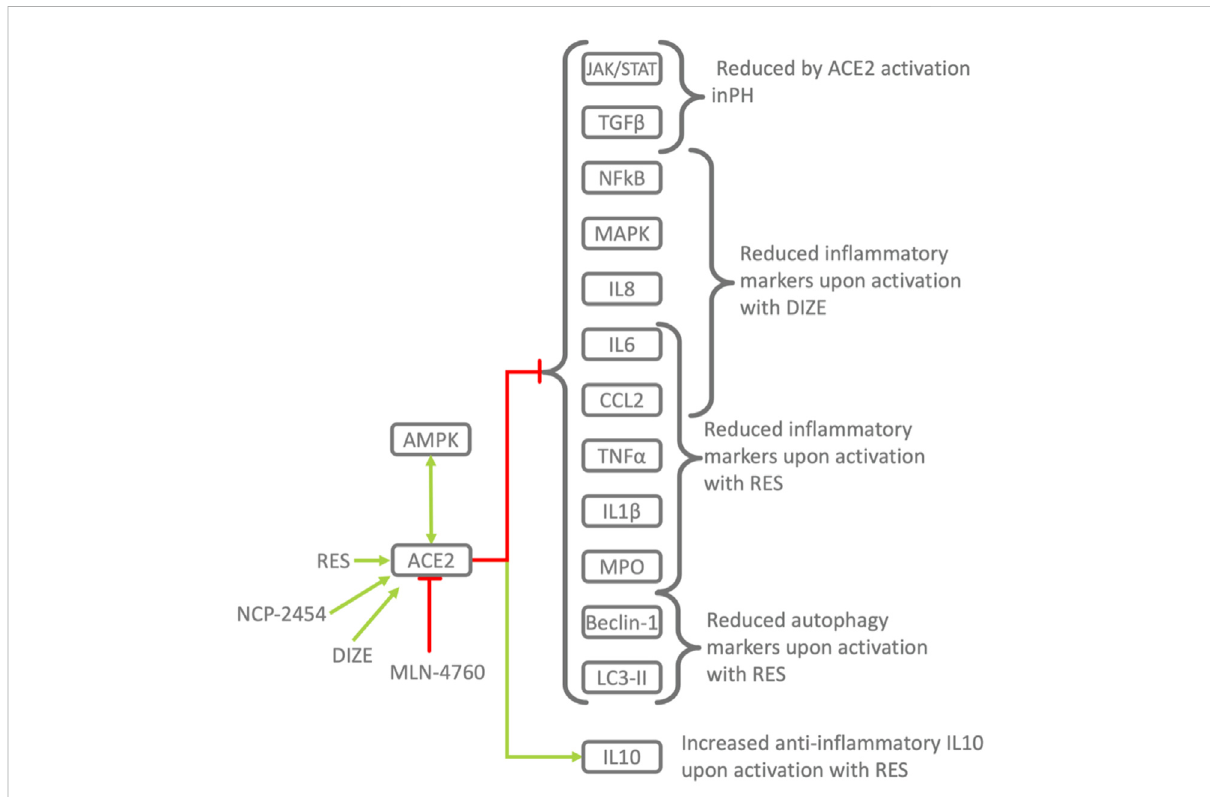
FIGURE 5 Pharmacologicalactivation/inhibition ofACE2 demonstrates itsprotective roleinin fl ammation. RES,ResorcinolnaphthaleinactivatesACE2 ina dose-dependent manner (Hernández Prada et al., 2008) and leads to decrease in pro-in fl ammatory TNF α , CCL2, IL6 and increase in anti- in fl ammatory IL10 improving endothelial dysfunction in PH (Li et al., 2012). Activation of ACE2 by RES alleviates the severity of ALI the lung, while ACE2 downregulation and pharmacological inhibition leads to the opposite effect. Similar mechanisms were observed in other diseases. PhosphorylationofACE2byAMPKintheendotheliumleadstoitsactivationandmitigates PH,pulmonaryhypertension(Zhangetal.,2018).Inanimal modelsofPH,activation ofACE2 bytheRAS,renin-angiotensin system improvesendothelia-dependent vasorelaxation,decreases proin fl ammatory TNF α , CCL2, IL6 and increases anti-in fl ammatory IL10 (Li et al., 2012) and ACE2 activator reduces monocrotaline-induced PH by suppressing the JAK/STAT and TGF β (Haga et al.,